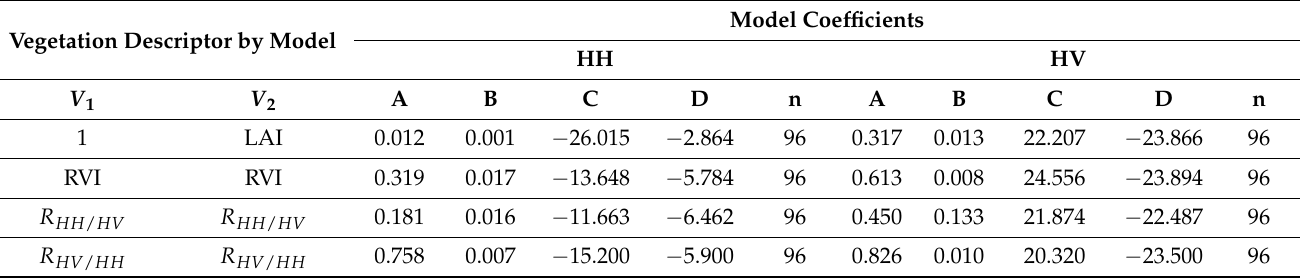
Table 3. Fitting of the WCM using HH and HV polarization.